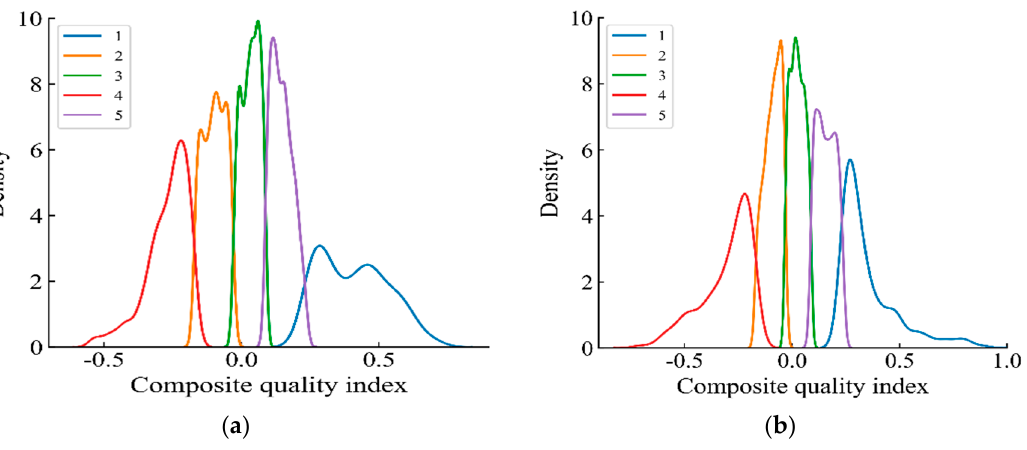
Figure 8. Gaussian density distribution of the clustering categories: ( a ) density distribution map of the cluster class in well A; ( b ) density distribution map of the cluster class in well B.